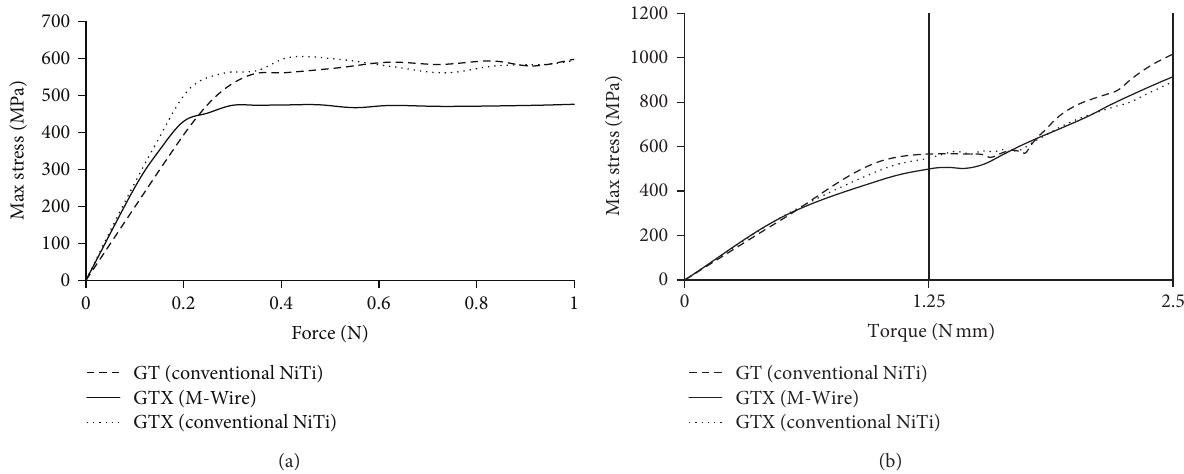
Figure 6: (a) Evolution of the maximum stress for bending simulation (up to 1N). (b) Evolution of the maximum stress for torsion simulation (up to 2.5